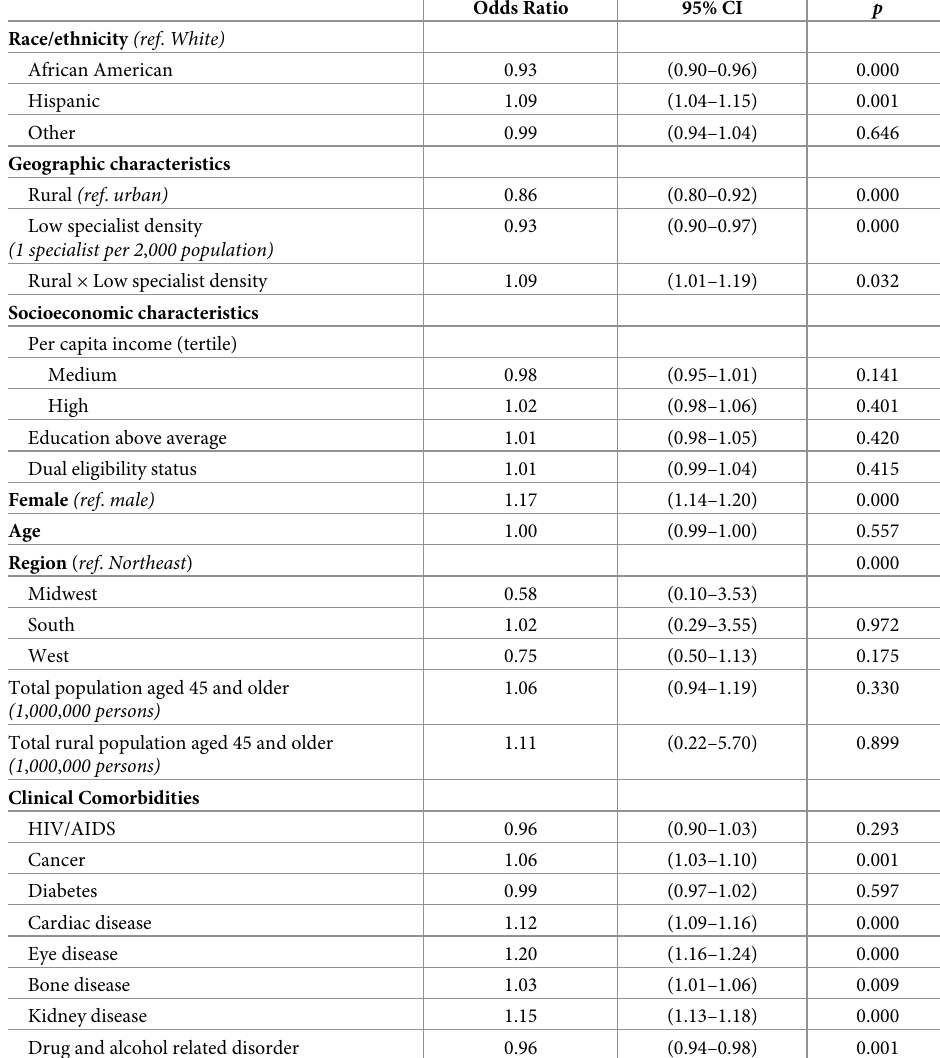
Table 4. Adjusted odds ratios of undergoing semi-annual hepatocellular carcinoma screening with ultrasound among Medicare beneficiaries with hepatitis C and cirrhosis (N = 200,319). Odds Ratio 95% CI p Race/ethnicity (ref .